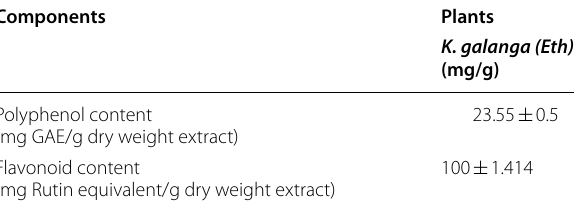
Table 2 Quantitative analysis of total flavonoid and polyphenol content